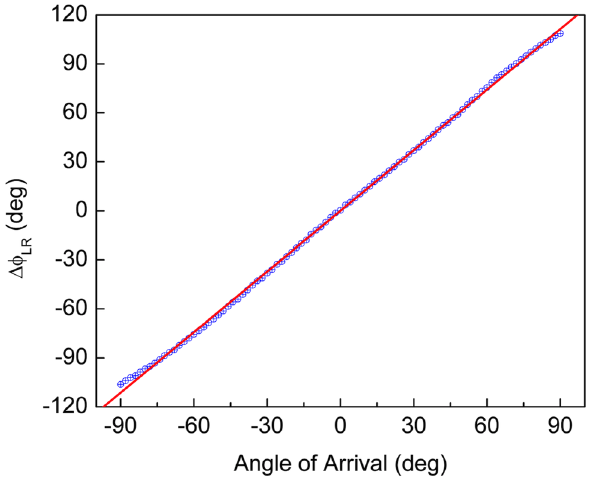
Figure 11. Phase shift between left- and right-wing signals as a function of varying acoustic wave direction of arrival (DOA). Measurements were taken every 2° in the angular range from − 90° to +